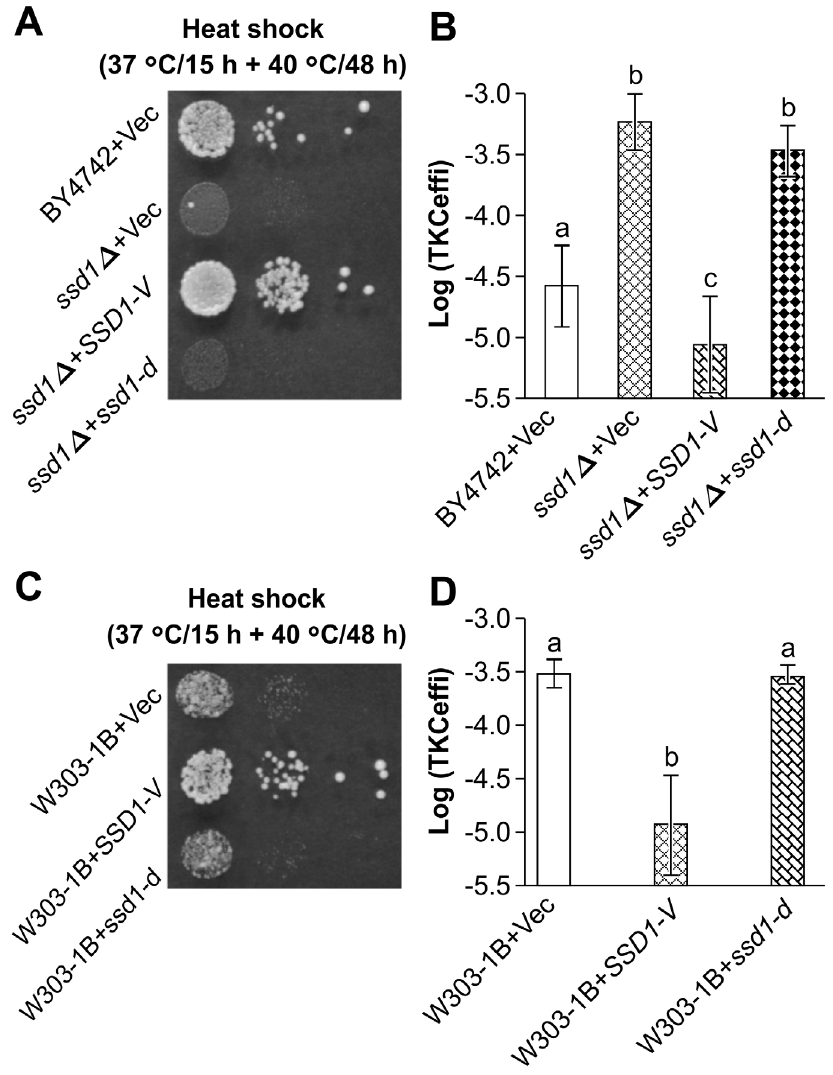
Figure 2. Functional complementation of SSD1 mutation rescues its temperature sensitivity as well as high TKC receptivity phenotype. Saccharomyces cerevisiae strains carrying a deletion (BY4742 ssd1 D ) or a strain spontaneously carrying the truncated SSD1 (W303-1B) was transformed with either the vector alone (vec), or vector carrying full length ( SSD1-V ) or vector carrying truncated ( ssd1-d ) genes. The growth phenotype on solid media at 37 u C for 15 h followed by 42 u C for 48 h with serial dilution (A) and (C); and the DNA transfer efficiency by the standard TKC procedure was measured (B) and (D). Complementation with the full length, functional SSD1 , but not the truncated gene rescued the phenotypes tested. Data are represented as mean 6 SD (n=15 in B and 6 in D, respectively). Letters above the bars indicate significant differences at p , 0.001 (Holm’s test). HB101 (pRH210, pAY205) was used as the donor.